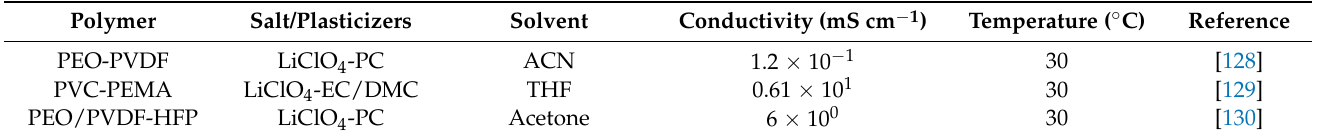
Table 6. List of GPEs with BaTiO 3 filler with their conductivity and